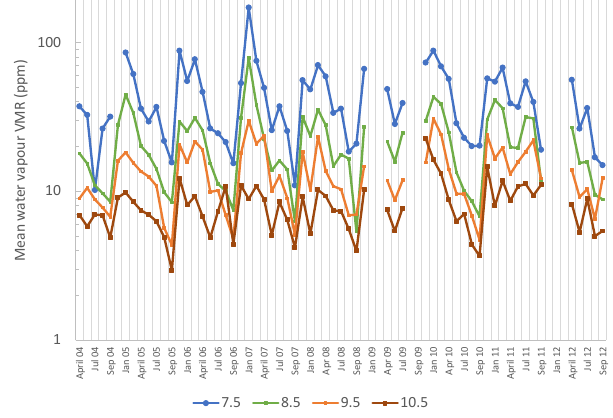
Figure 3. Monthly mean time series of the MAESTRO water vapour mixing ratio at different heights (indicated in legend, in km) in the southern high-latitude tropopause region. Months of Febru- ary, June, October, December are not included as ACE does not sample in this region during those months. Discontinuities indicate insufficient data during the other 8 calendar months. A logarithmic scale is used for the y